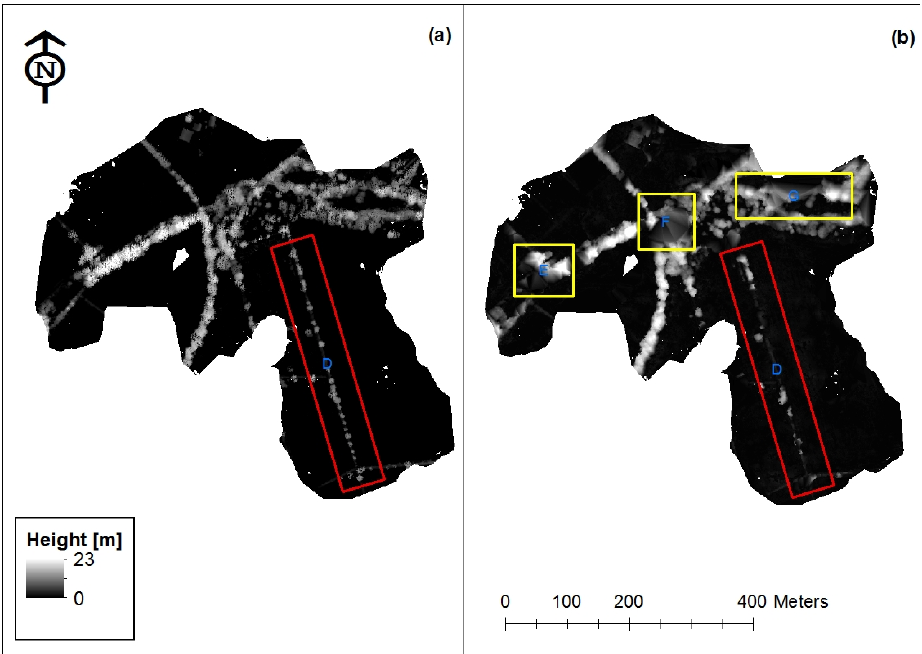
Figure 10. Showing ( a ) LiDAR CHM and ( b ) SfM CHM for the Meshaw site. The Red box D shows how SfM has missed a number of small trees which are present in the area, while the yellow boxes E, F and G show the presence of TINing artefacts.